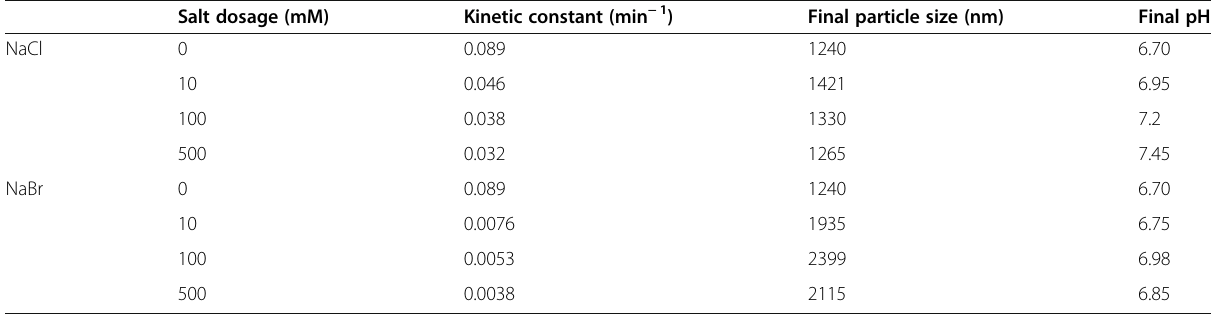
Table 1 Effect of NaCl and NaBr on the observed rate constant (min − 1 ), final average particle size (nm) measured by DLS, and the final pH